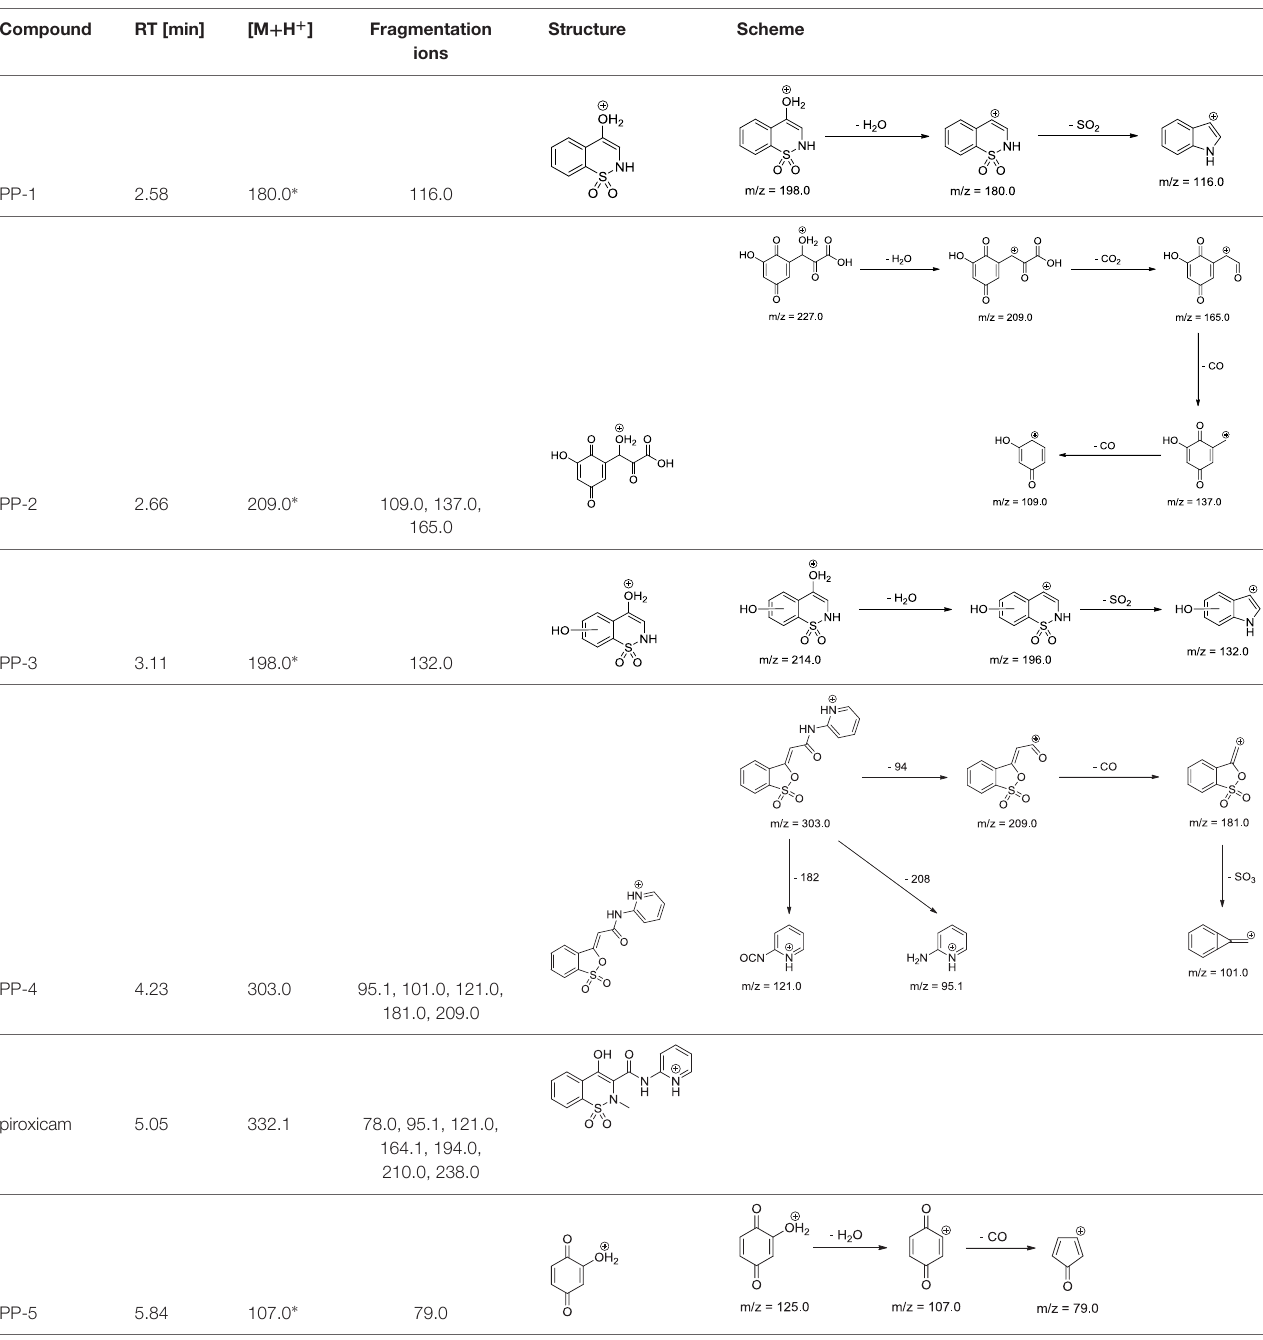
TABLE 1 | Proposed structures and fragmentation pattern of piroxicam by mycelium from in vitro cultures of Lentinula edodes .